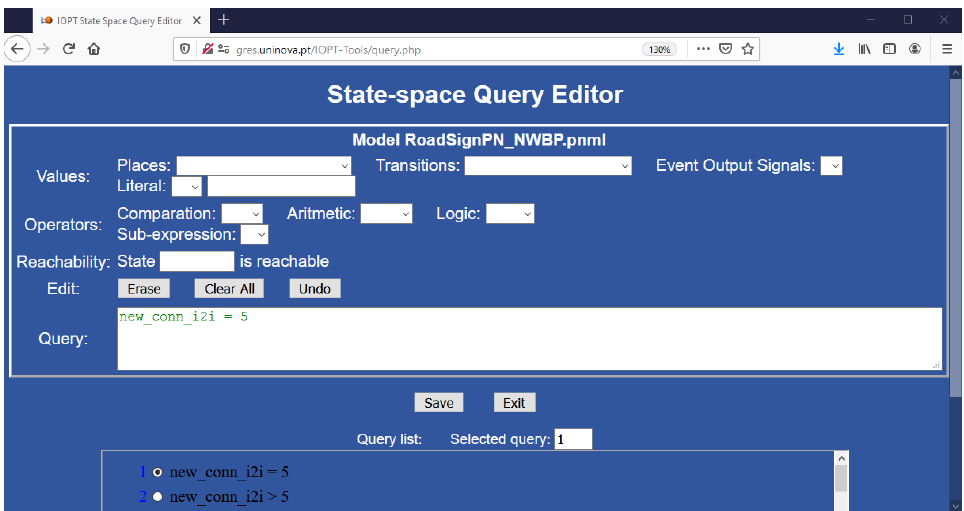
Figure 7. State-space of the controller model of the NWBP module.